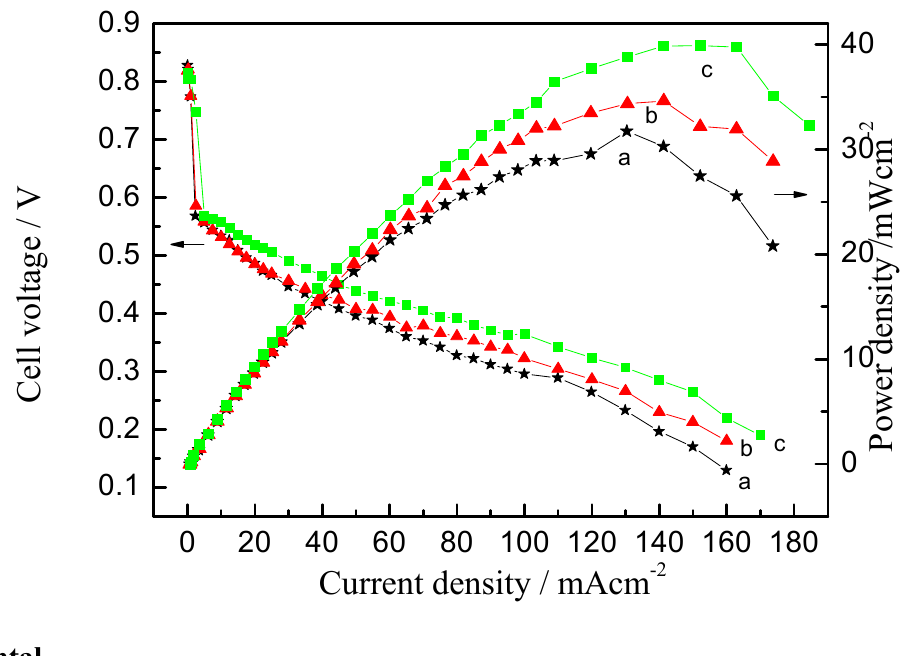
Figure 7. Performance comparison of the passive direct methanol fuel cells (DMFCs) with cathode catalytic layer made from the ink pre-heated at ( a ) 25 °C; ( b ) 50 °C and ( c ) 80